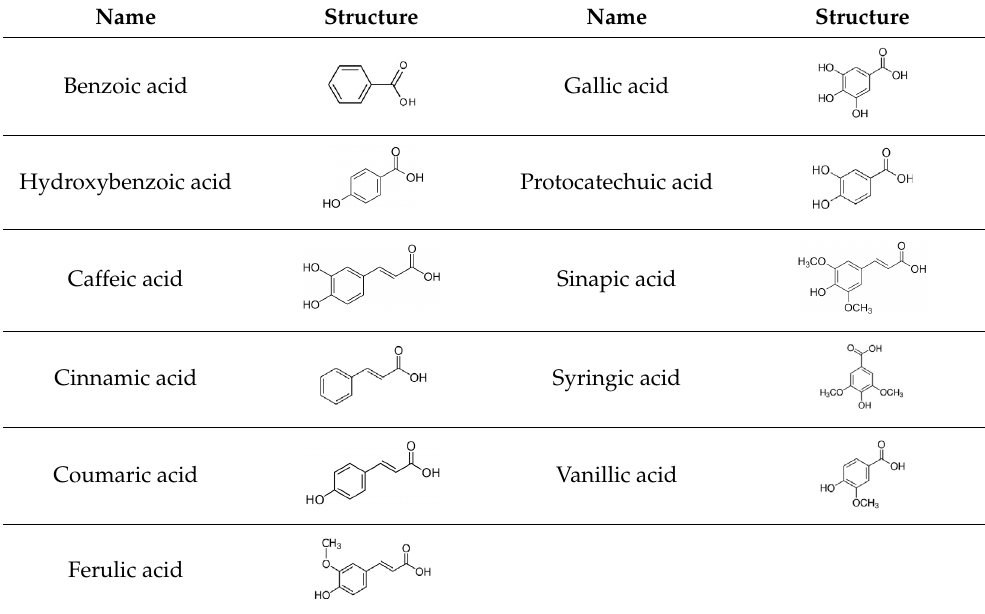
Table 1. The structure of phenolic acids.